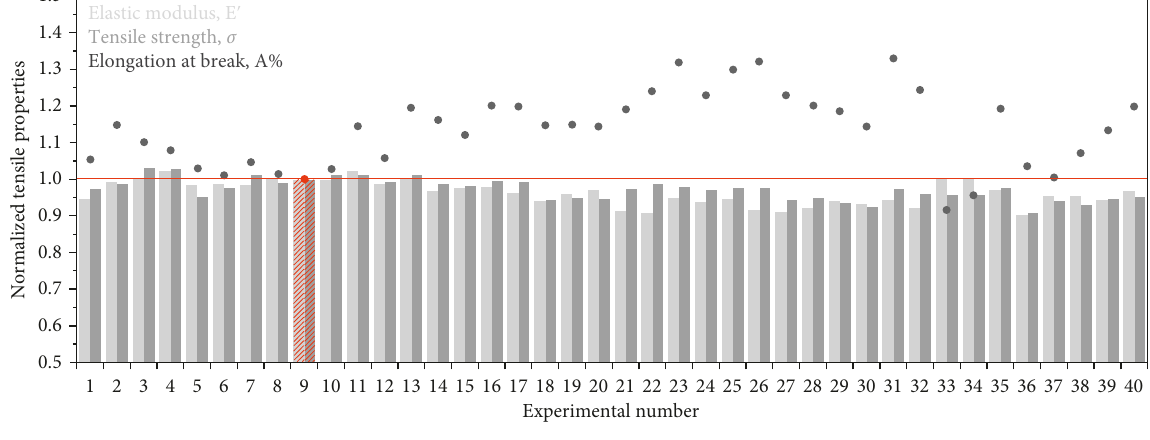
Figure 9: Normalized tensile properties of sintered parts compared to exp. N ° 9. The red line corresponds to exp. N ° 9, which represents the parameters recommended by the